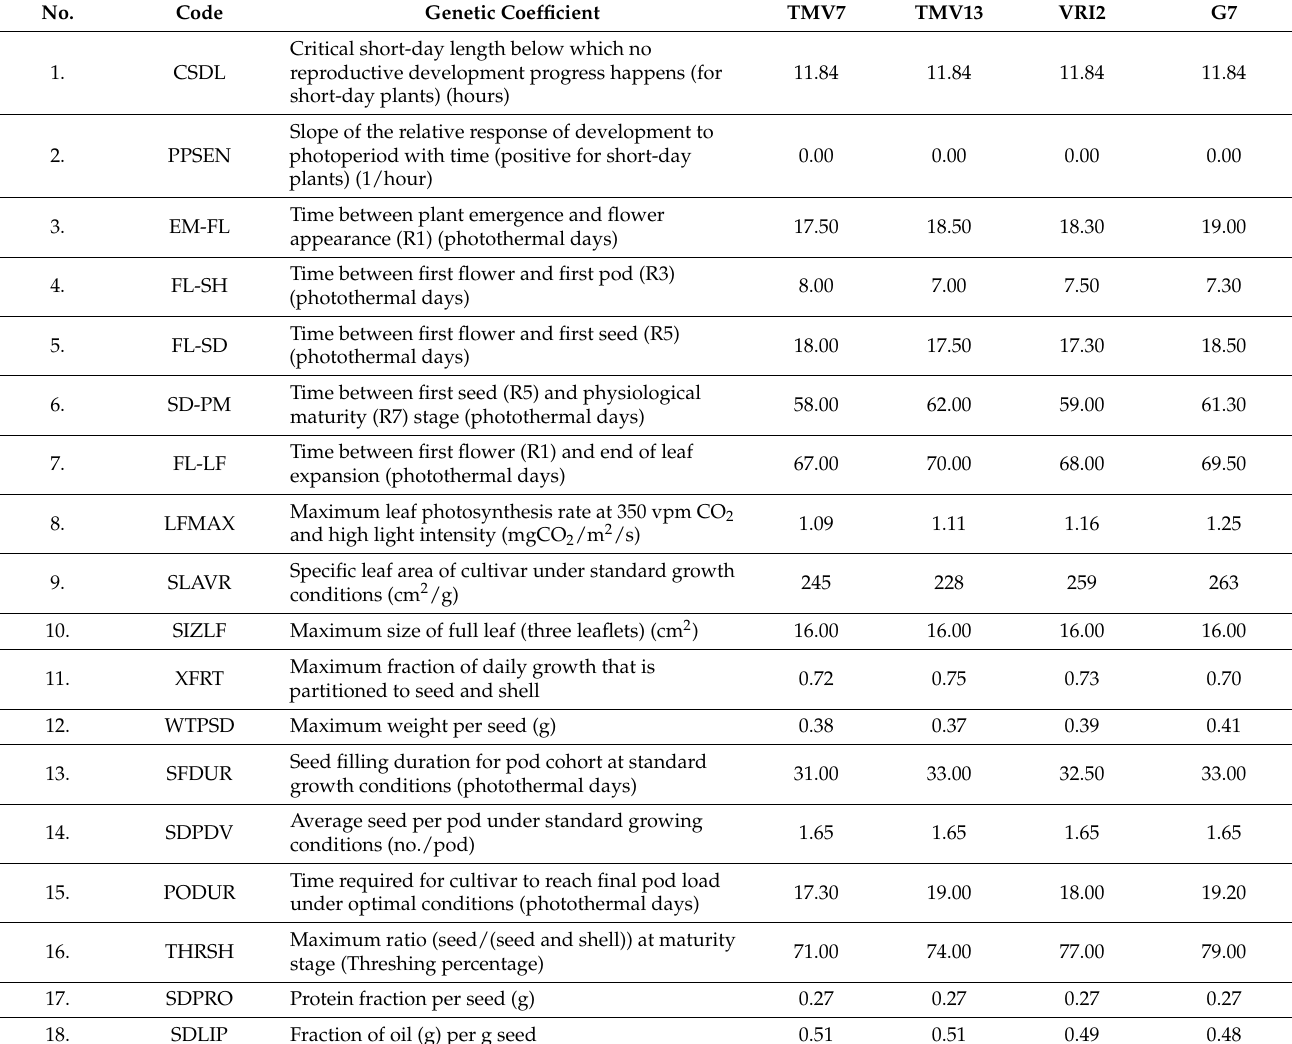
Table 3. Developed genetic coefficient for predominant varieties of peanut in the Tiruvannamalai district of Tamil